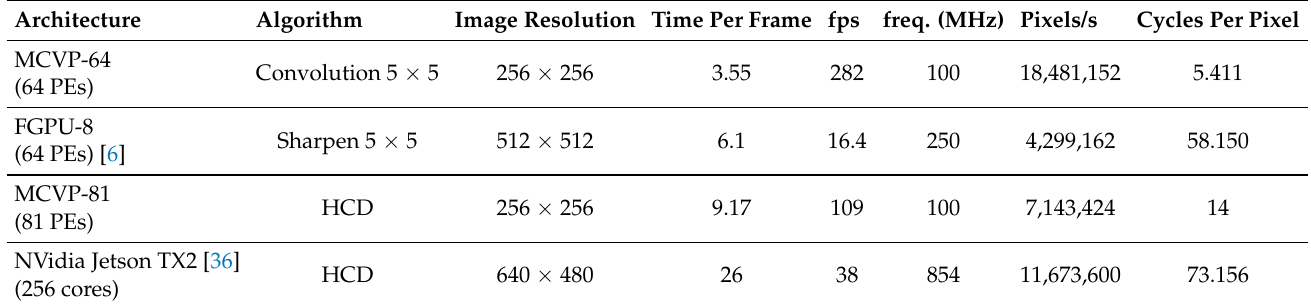
Table 6. Efficiency comparison